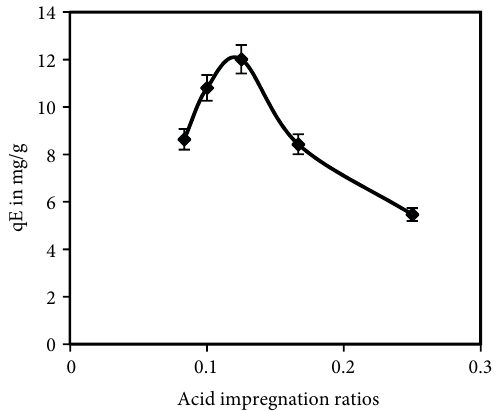
Fig. 2. Effect of acid impregnation ratios at 20% by weight acid concentration at 30 °C and speed of stirring 150 rpm